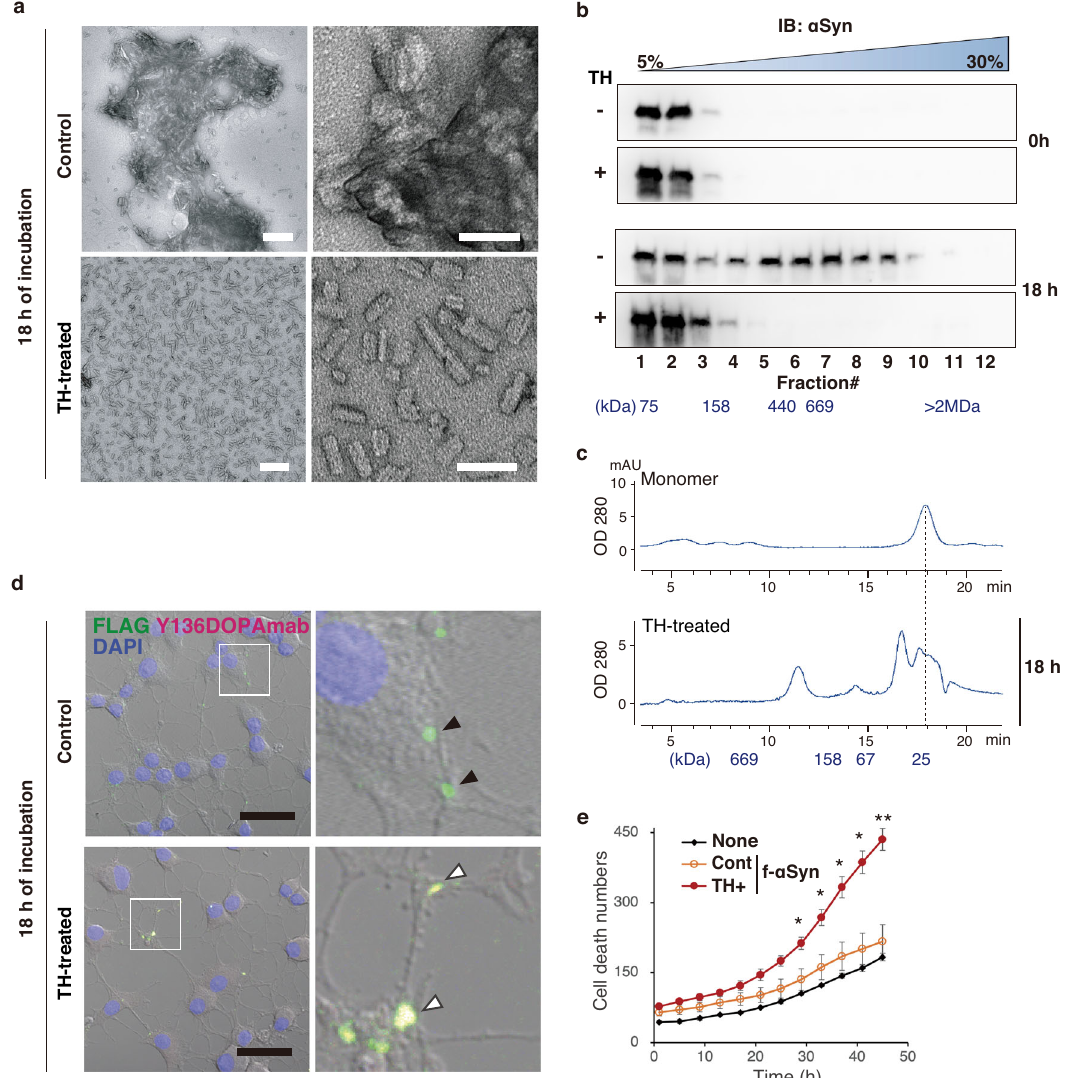
Fig. 4 | Oligomerformationand cytotoxicityofdopanized f- α Syn. a Negatively stainedTEMimagesofFLAG-tagged α Syn(f- α Syn).Control(upper)andTH-treated (lower) f- α Syn were incubated for 18h before staining with 2% uranyl acetate. Control f- α Syn formed large fi bril clusters, whereas dopanized f- α Syn tended to form a separated oligomeric conformation. High-magni fi cation images are shown on the right side of each panel. Scale bars: 200nm (left) and 50nm (right). b WB analysisof the sucrose gradient fractionation off- α Syn. Before (0h) or after (18h) incubation, control (TH − ) and dopanized (TH+) f- α Syn were separated by 5 – 30% sucrosegradientcentrifugation.Twelve1-mLfractionswereexaminedbyWBusing ananti- α Synantibody.Thecorrespondingsucroseconcentrationsareindicatedat the top of the panels. After 18h of incubation, control f- α Syn formed aggregates with large masses, whereas dopanized f- α Syn retained a smaller mass. c SEC of dopanizedf- α Synoligomers.The chromatogramof SECusing monomeric(upper) orTH-treatedf- α Synafter18hofincubation(lower)showedthatdopanizedf- α Syn